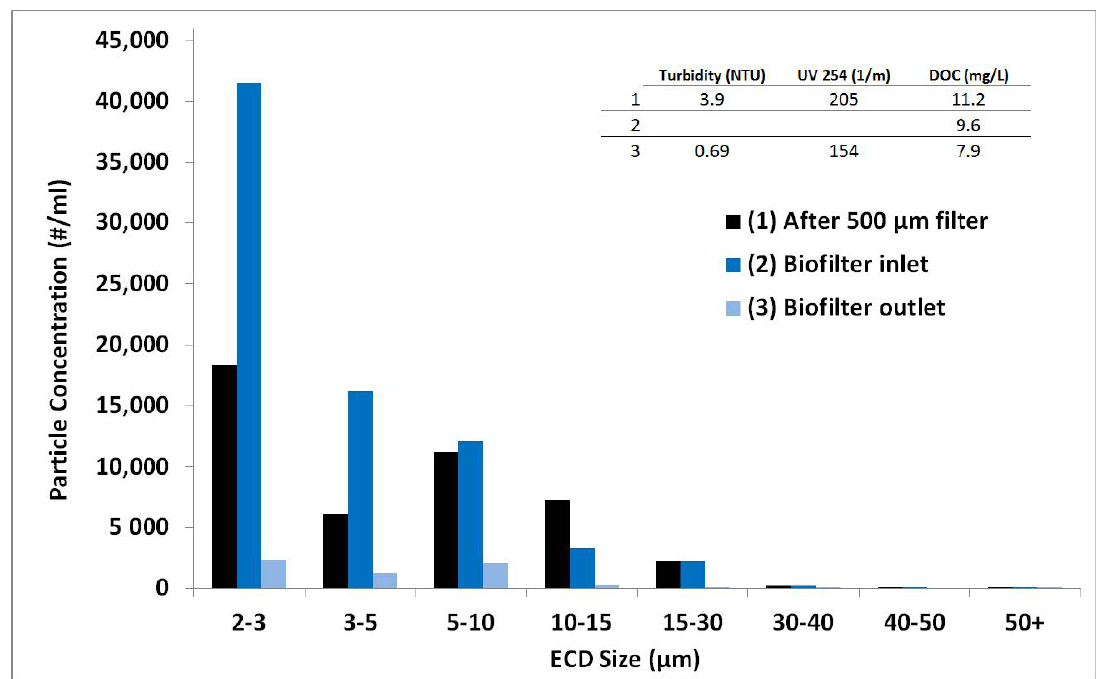
Figure A4. Particle-size distribution (PSD) analysis of a representative sampling campaign with H 2 O 2 .